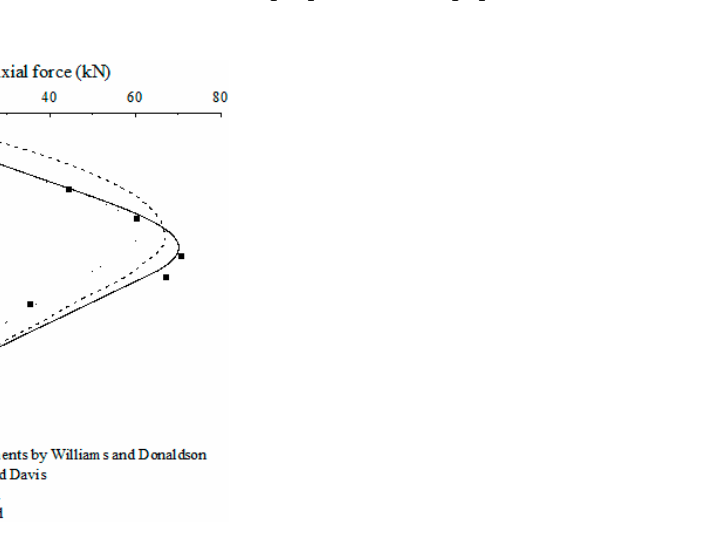
Figure 8. Comparison and validation of the axial force on the pile with the measurement results [9,12].